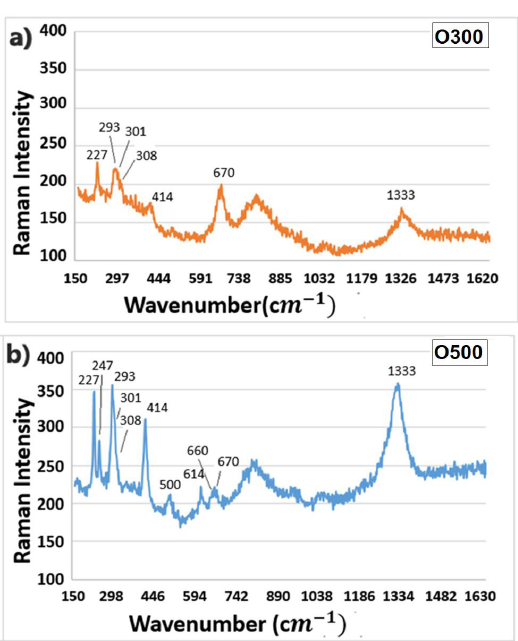
Figure 5. X-ray diffraction results of following samples: a) O300- 0.5h; b) O300-2.0; c) O500-0.5h.